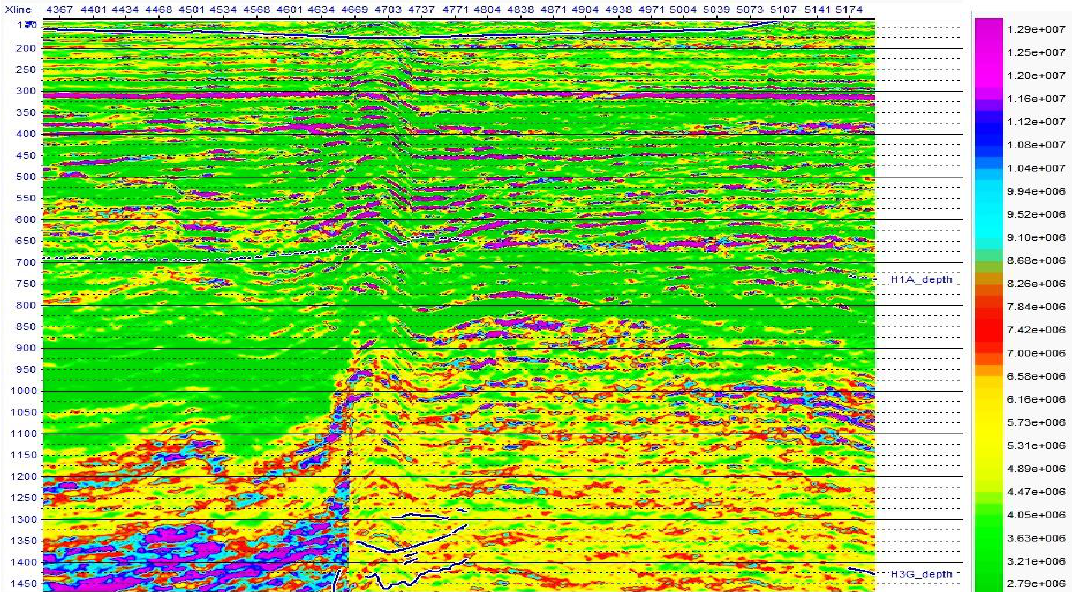
Figure 5. Illustrates the shear modulus of the block calculated from the seismic